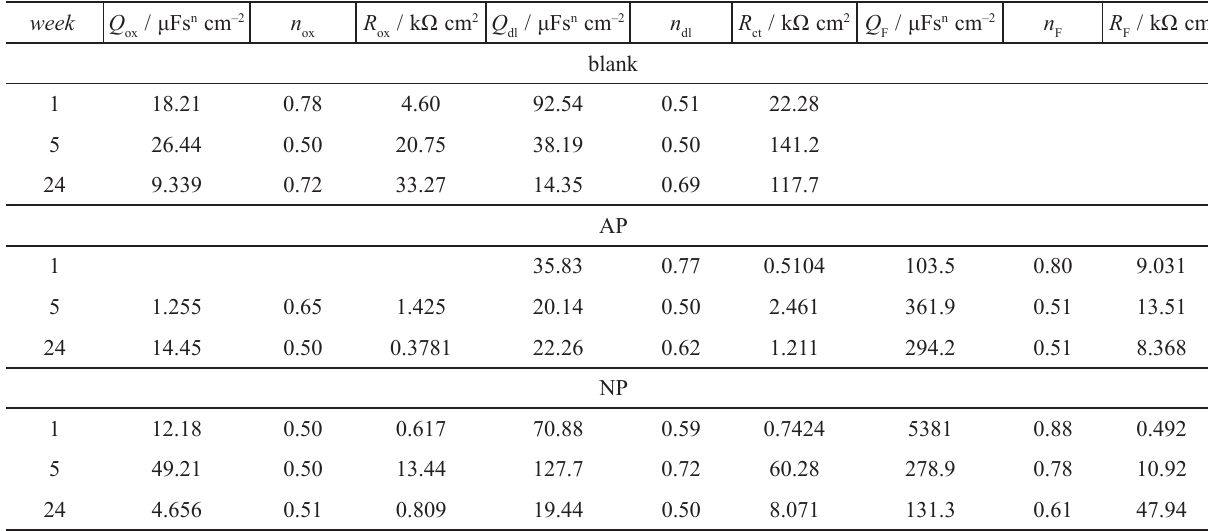
Table 2 – EIS data for CuSn6 samples